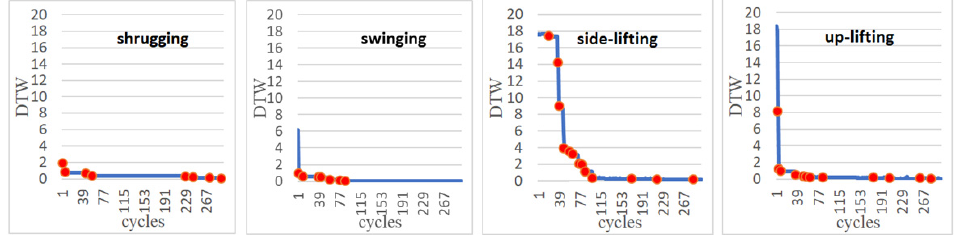
Figure 7. Learning progress of the ANM system such that the four motors started at the same time (Red dots represent where learning performance has improved).